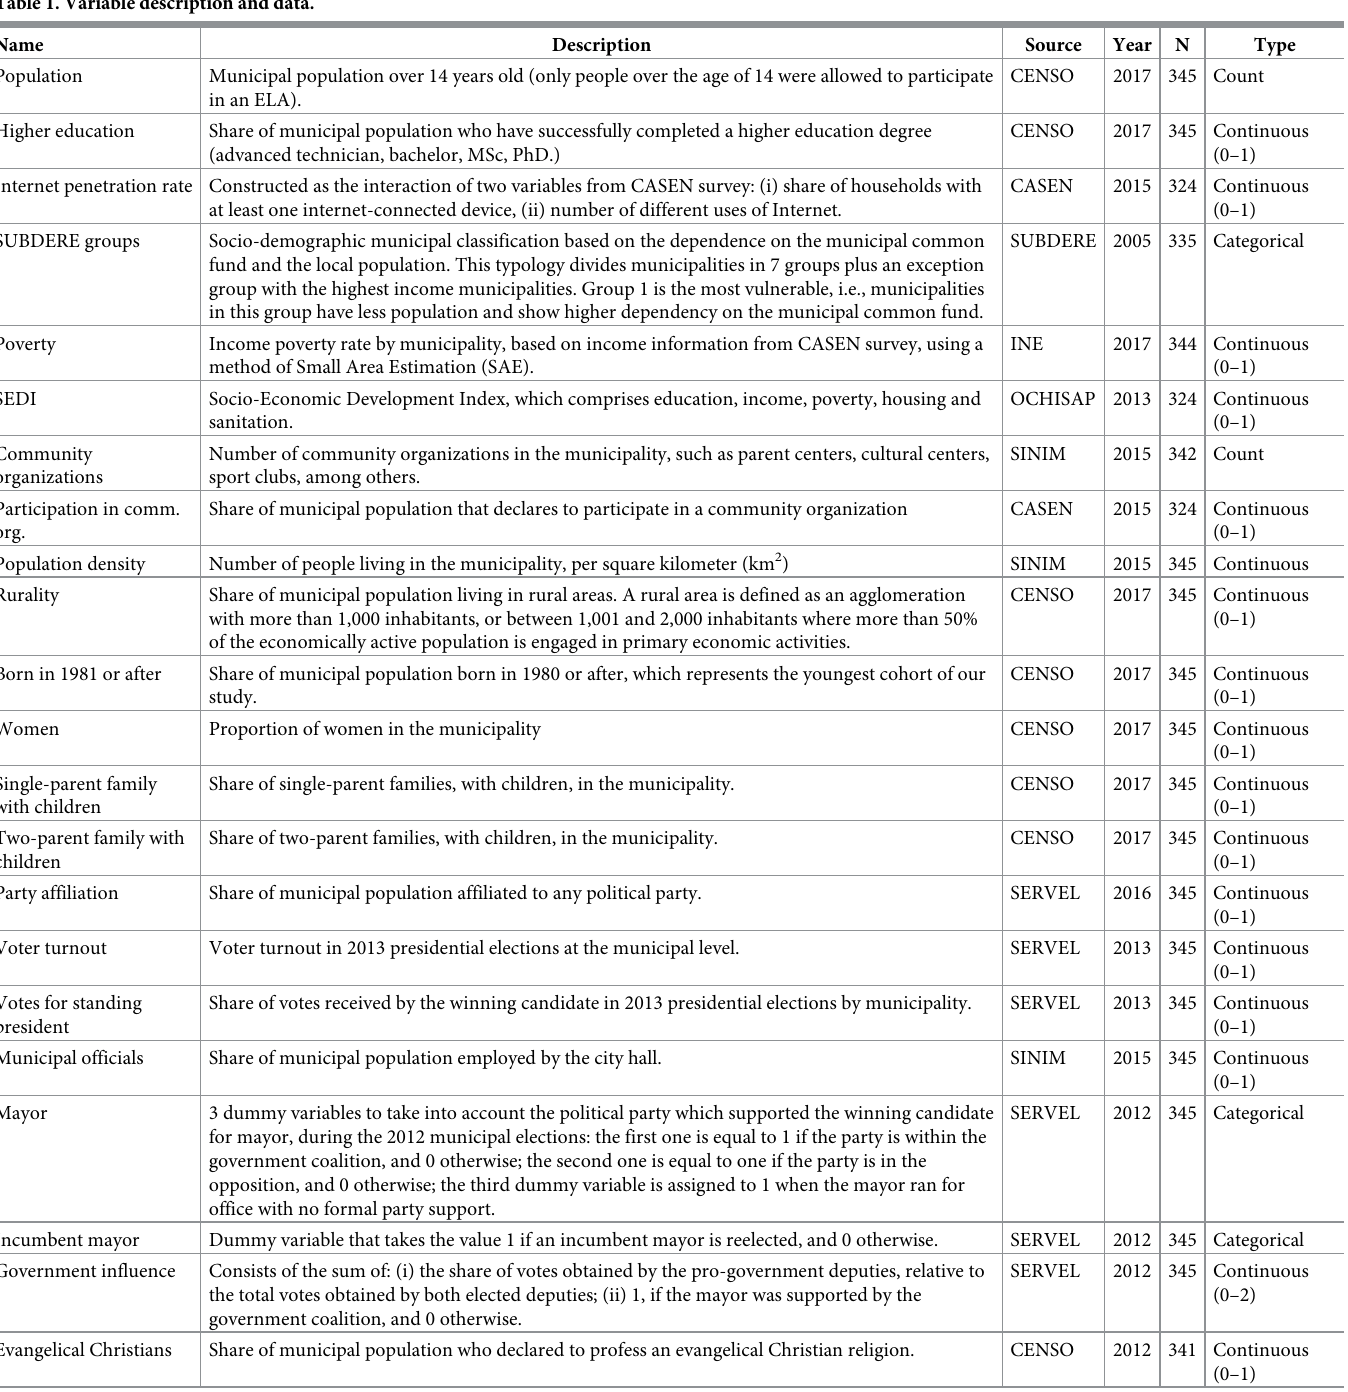
Table 1. Variable description and